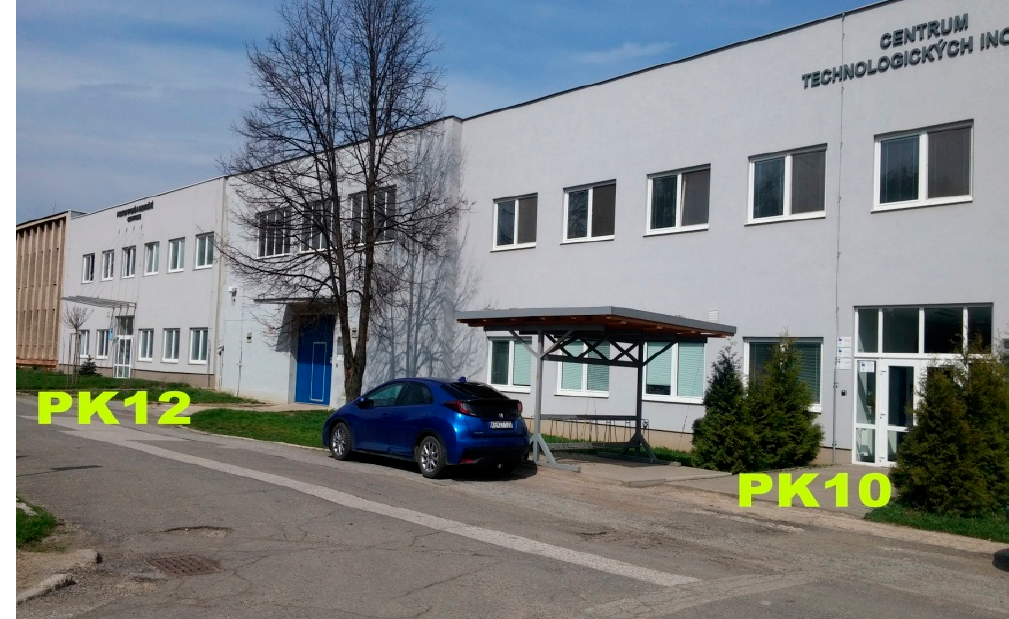
Figure 2. Front views on entrance halls—PK10 and